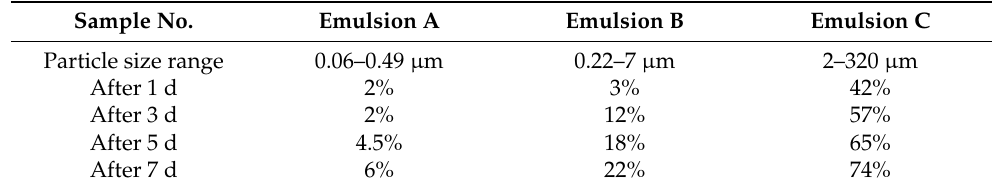
Figure 4. Stability of emulsions prepared at ( a ) 400, ( b ) 270, and ( c ) 180 kHz for 7 d. Color scale: blue to red represents increasing time. Table 4. Stability of emulsions prepared at (emulsion A) 400, (emulsion B) 270, and (emulsion C) 180 kHz over 7